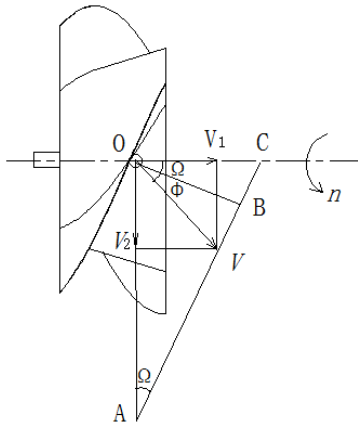
Figure 6. Velocity analysis of the peanut root disk on the screw-feeding blade.